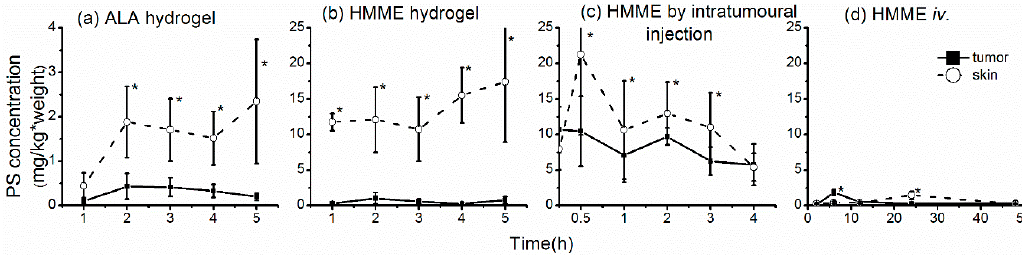
Figure 4. Concentrations of photosensitizer in subcutaneous tumors and skin after administration by various routes. ( a , b ) Levels of 5-aminolevulinic acid ( a ) and hematoporphyrin monomethyl ether (HMME) ( b ) were measured in tumor and skin samples after application of hydrogels to the skin overlying the tumor; ( c , d ) HMME levels were measured in tumor and skin samples after injection in phosphate-buffered saline intratumorally ( c ) or intravenously ( d ). Photosensitizer concentrations are presented as mg/kg of tissue. The asterisks * mean significant difference ( p < 0.05) between the two tissues at the same time point.